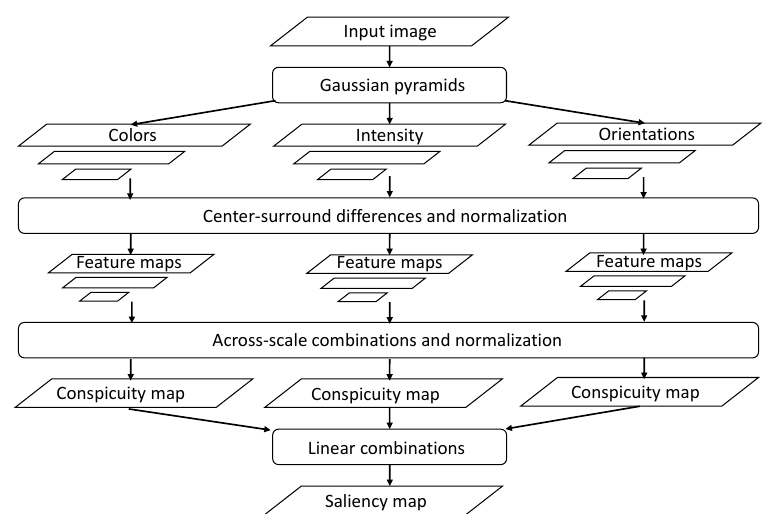
Figure 3. Flowchart of Itti’s saliency